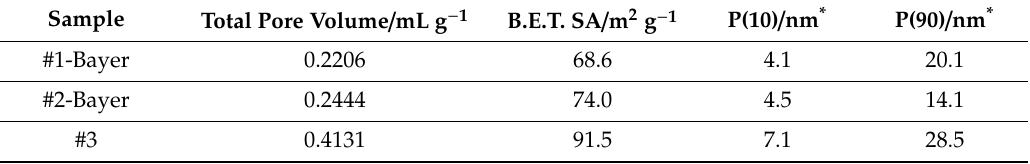
Figure 2. The pore size distribution curves of samples #1, #2, and #3; ( a ) sample #1, ( b ) sample #2, ( c ) sample #3. Table 3. A comparison of the pore concentration region between the three alumina samples. Sample